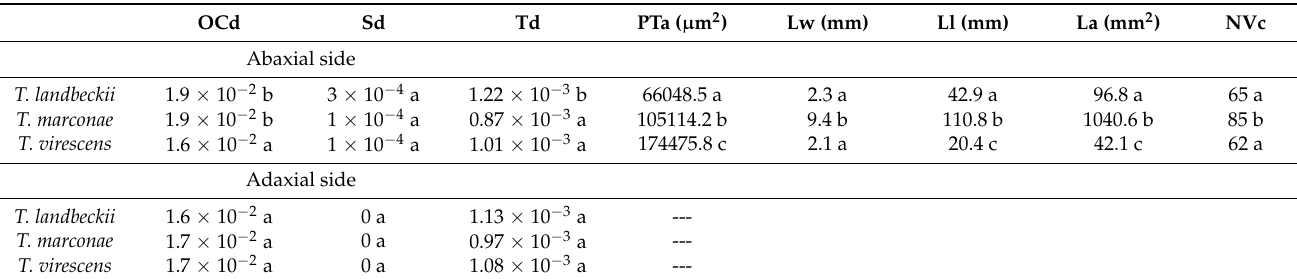
Table 1. Leaf anatomical comparison between Tillandsia landbeckii , T. marconae, and T. virescens . Duncan’s test ( p < 0.05). Equal letters represent statistical equality [26]. OCd = ordinary cell density; Sd = stomatal density; Td = trichome density; PTa = peltate trichome area ( µ m 2 ); Lw = leaf width